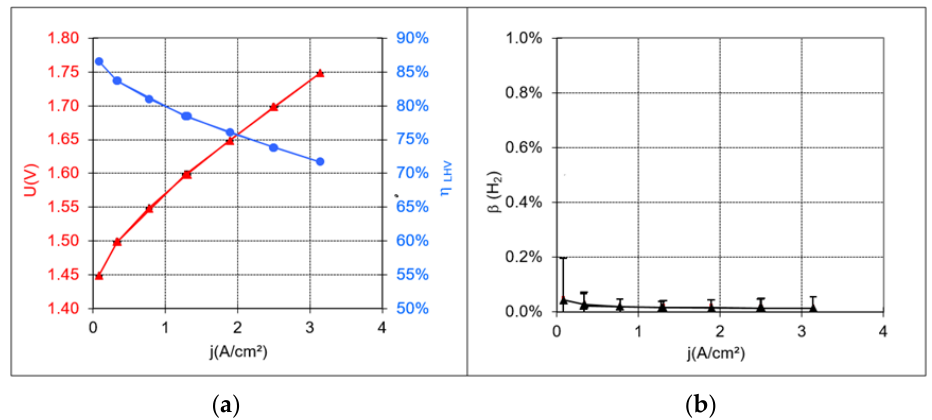
Figure 5. Results from the characterization measurements of an MEA sample. ( a ): Polarization curve (red) and cell efficiency (blue) in relation to the lower heating value η L = 1.25 V/U Cell ; ( b ): H 2 volume fraction in O 2 .